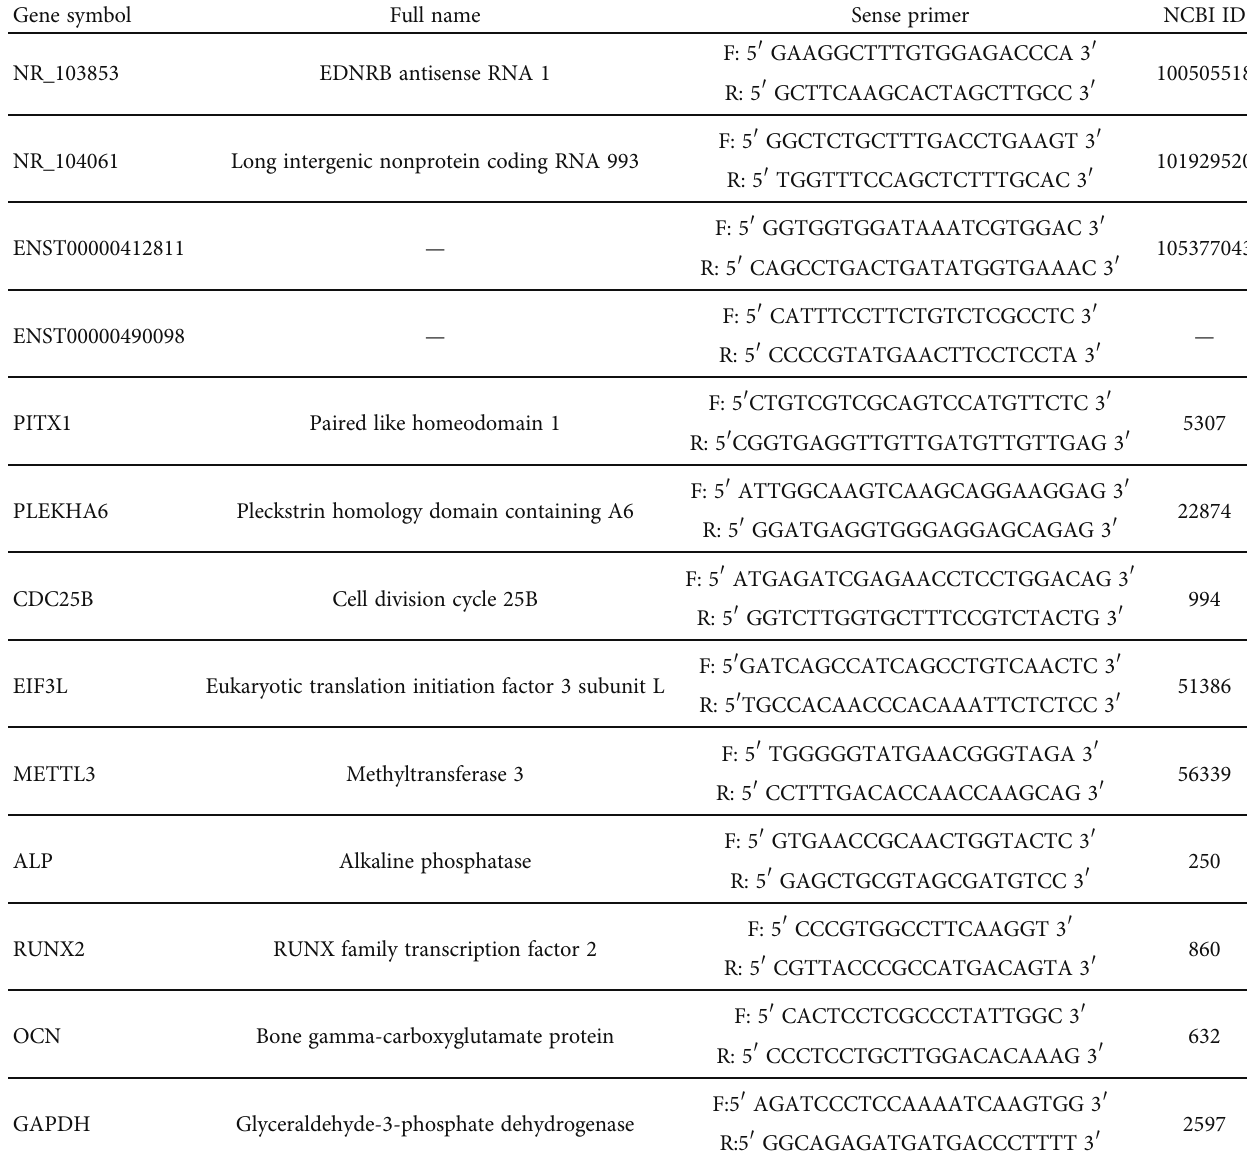
Table 1: Primers for